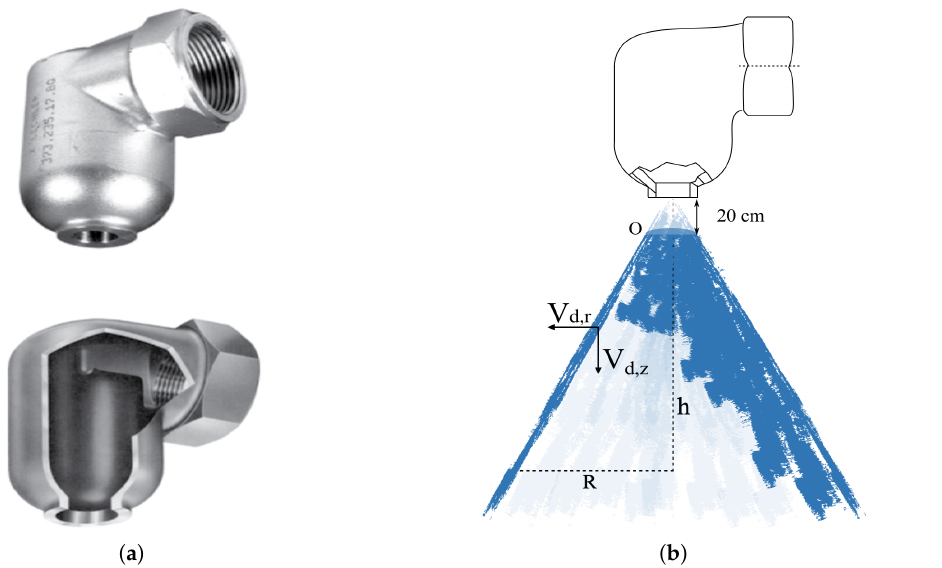
Figure 2. ( a ) Ramp bottom nozzle and its section view [41]; ( b ) hollow cone spray with fine droplets. h , the vertical distance from the nozzle; R , the radial distance from the spray central line; O , the numerical injection plane.